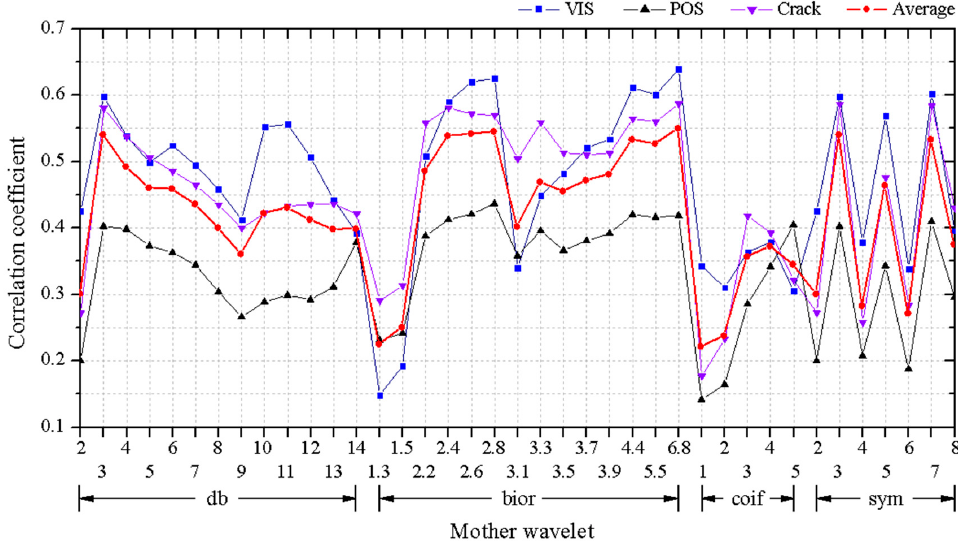
Figure 5. Correlation coefficient between the single PD pulses and the mother wavelets.